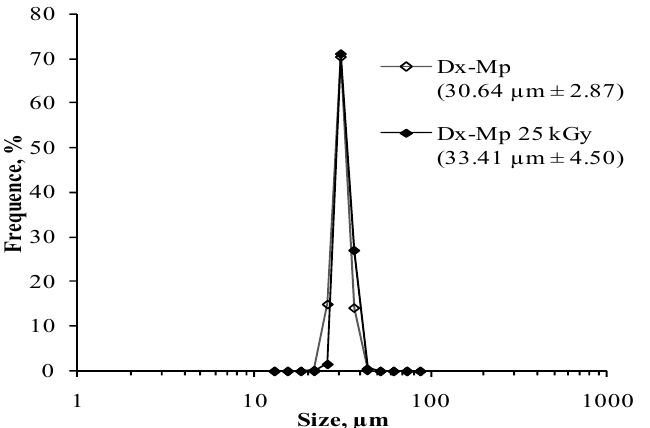
Figure 2. Particle size distribution of dexamethasone-loaded microspheres (53–20 µm): ◊ before and ♦ after sterilization.